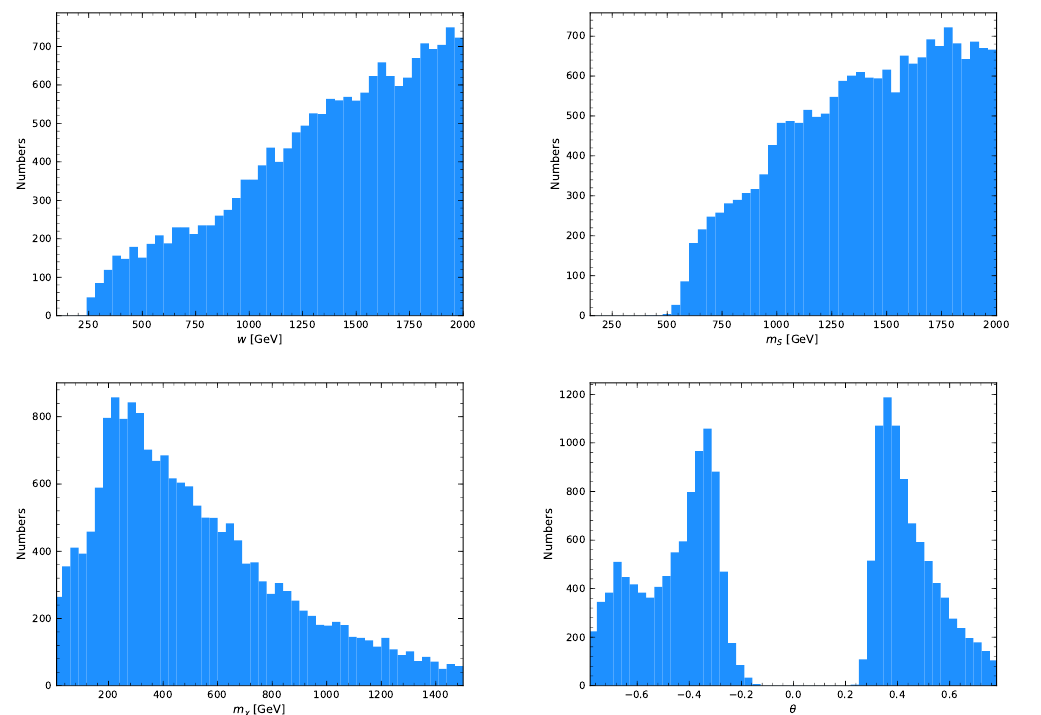
Figure 2 . Distributions of parameters that can generate a su(cid:14)ciently strong (cid:12)rst-order EWPT. For each (cid:12)xed value of the parameter on the horizontal axis, all the other parameters are scanned in their respective full